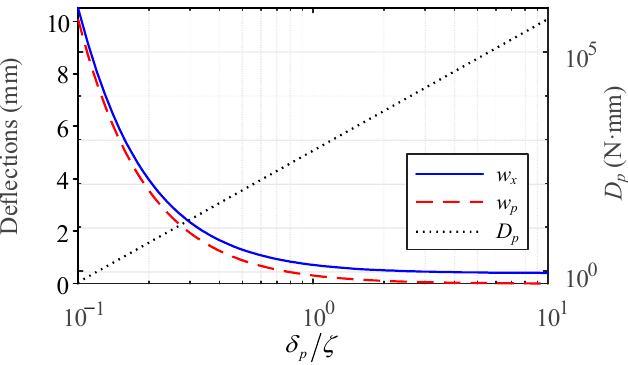
Figure 14. Deflections as a function of ratio 𝛿 (cid:3043) /𝜁 .